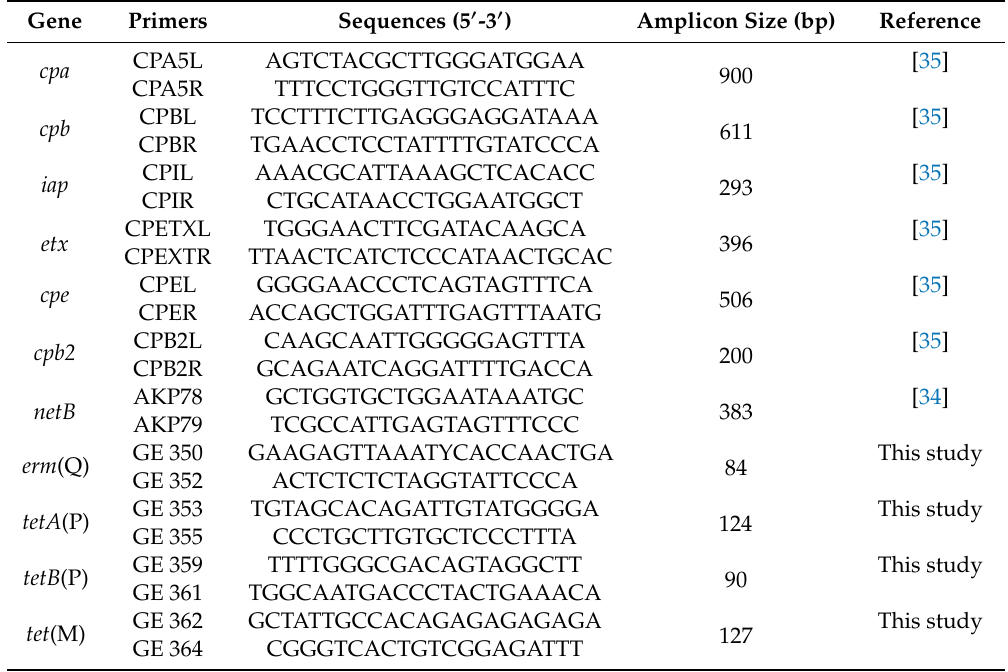
Table 2. Primers used for the detection of C. perfringens toxin genes and antimicrobial resistance